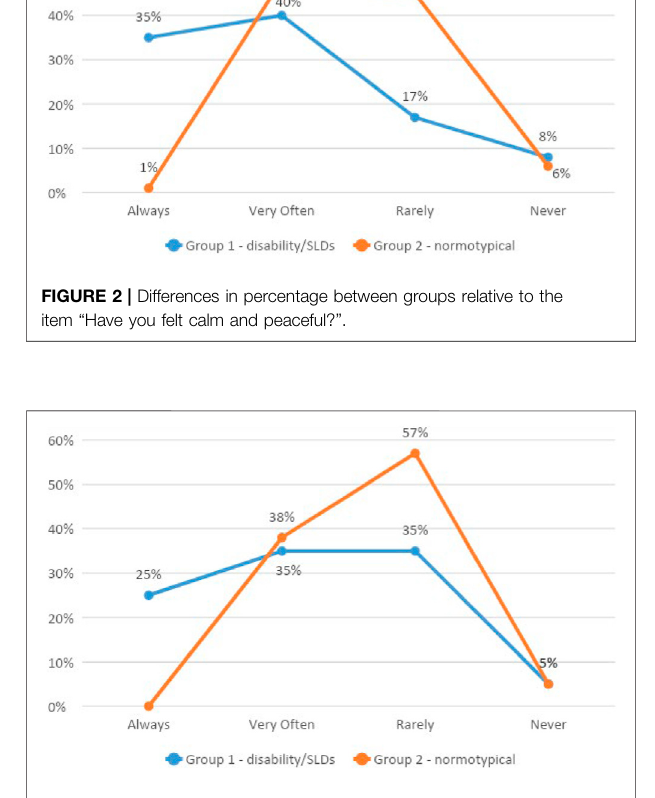
FIGURE 3 | Differences in percentage between groups relative to the item “ Did you have a lot of energy? ” .